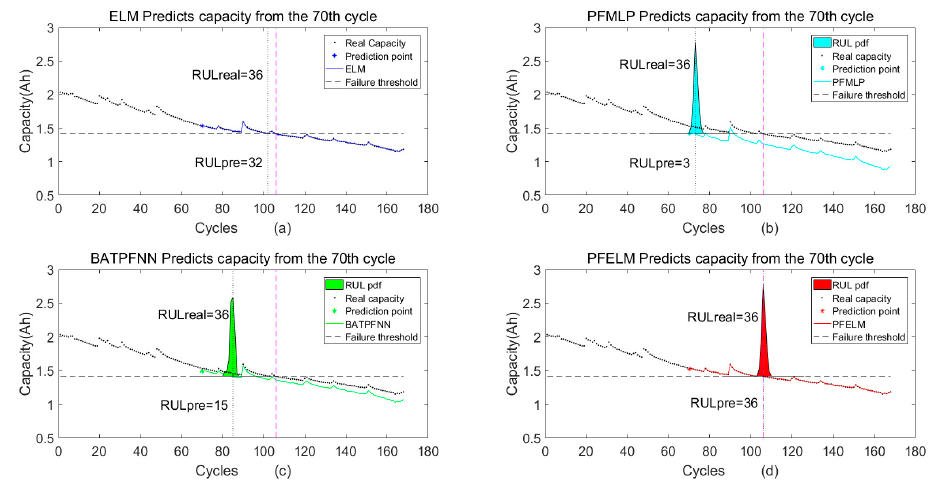
Figure 13. Capacity prediction error from the 50th cycle.